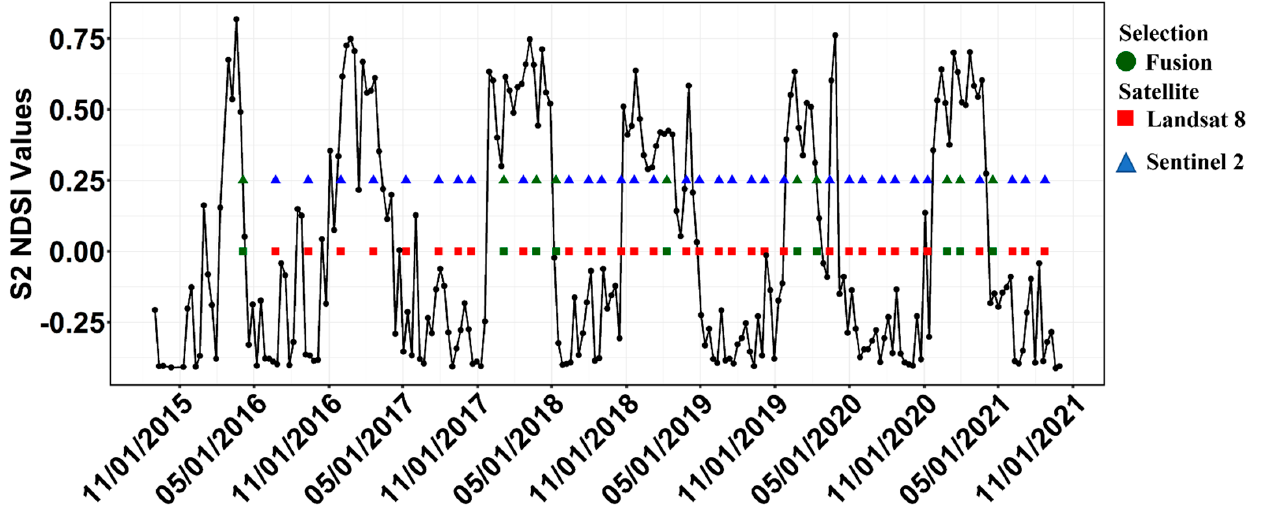
Figure 2. Chronogram of the 2015–2021 satellite acquisitions and NDSI values for the study area at each date of acquisition.